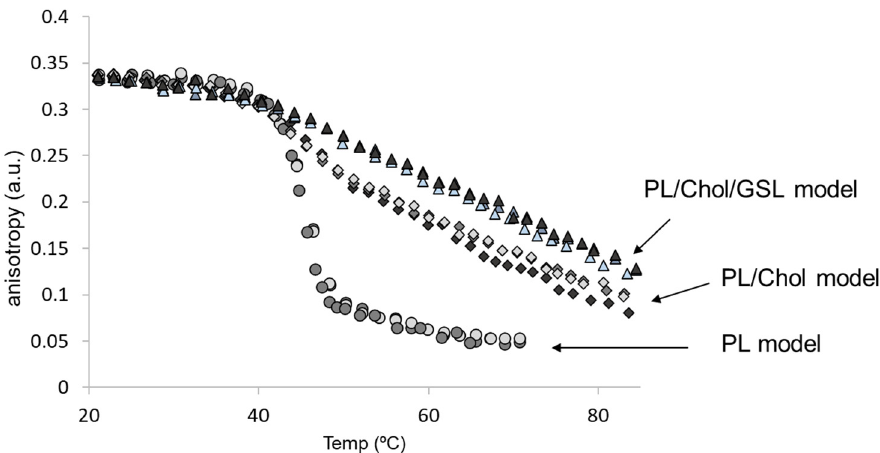
Figure 3. Anisotropy measurements (r s ) of DPH fluorescent labelled LUVs across the temperature range of 20 °C to 80 °C, obtained for the phospholipid (PL) model (DPPC/DSPC/DMPE, 0.50:0.28:0.22, circles), the phospholipid/cholesterol (PL/Chol) model (DPPC/DSPC/DMPE/Chol, 0.37:0.21:0.16:0.26, diamonds), and the PL/Chol/GSL model (DPPC/DSPC/DMPE/Chol/GSL, 0.28:0.15:0.16:0.24:0.17, triangles). Measurements in each system correspond to independent experiments (n = 3).